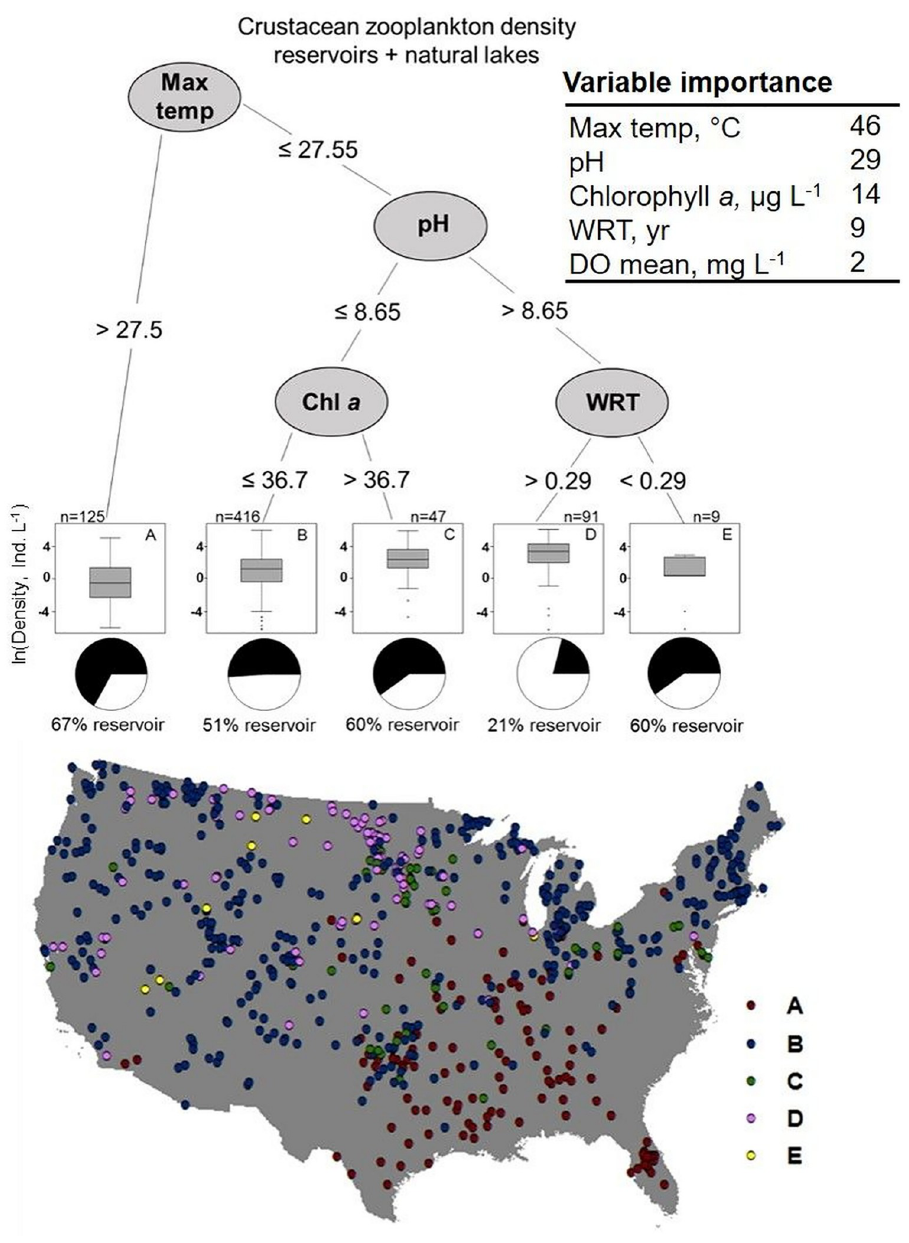
Fig 3. Regression tree analysis for crustacean zooplankton densities aggregated across all waterbodies in the U.S., with the locations of the waterbodies from the regression tree groupings shown with different colors on the map. In the pie charts, white refers to natural lakes and black refers to